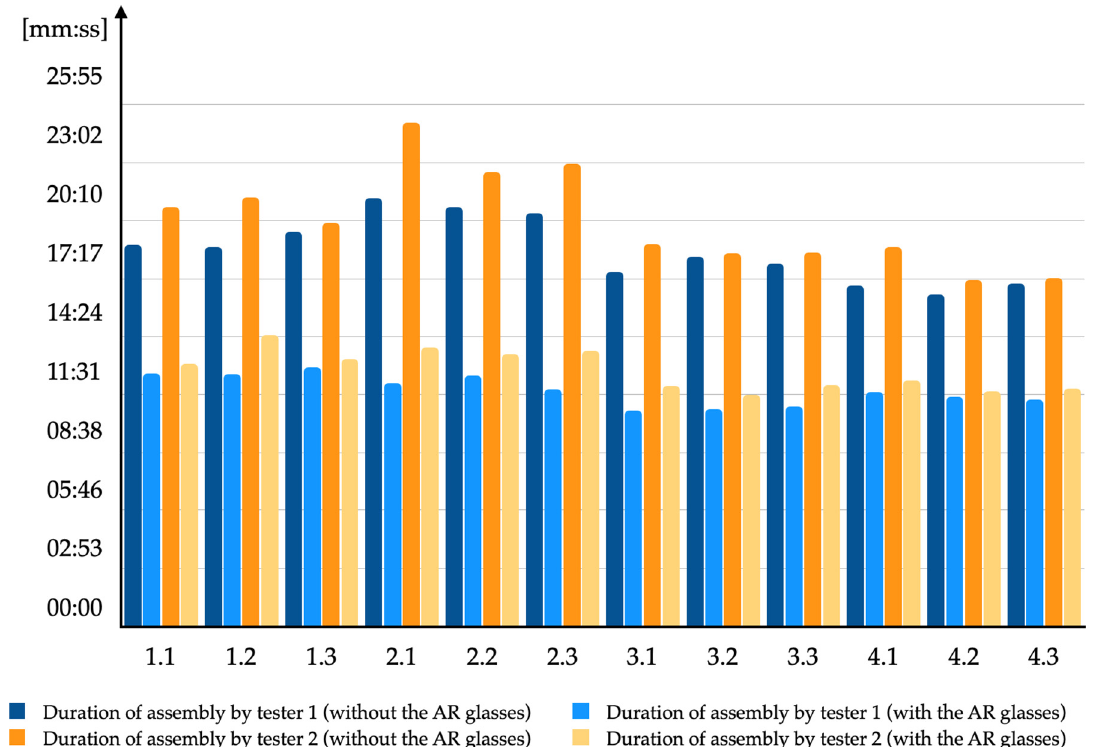
Figure 8. Measured values and calculations from all 48 tests.